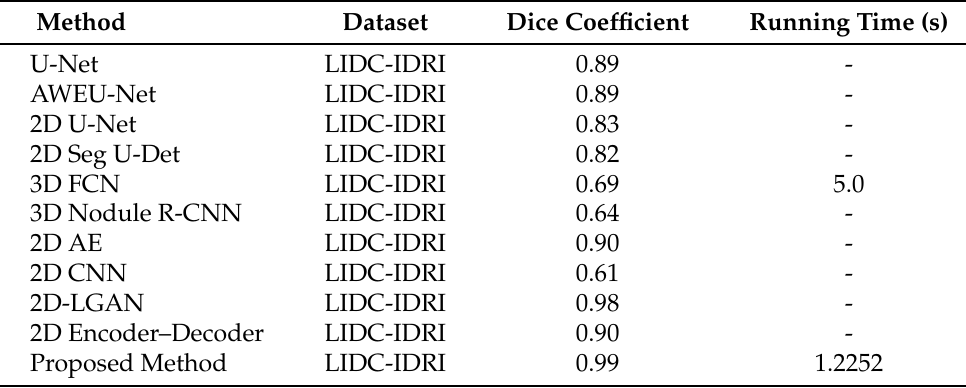
Figure 7. Segmented outputs using the proposed algorithm. The ( left ), ( center ), and ( right ) columns are the original CT images, segmented with a thick boundary, and the segmented output, respectively. Table 1. Quantitative comparison of different